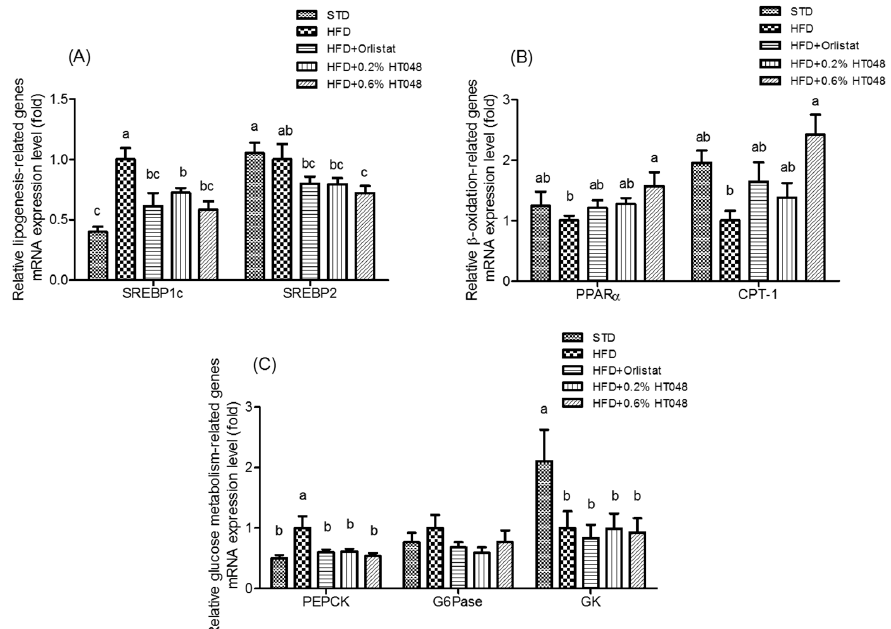
Figure 2. Effect of HT048 on mRNA expression of genes related to hepatic lipogenesis ( A ); β -oxidation ( B ); and glucose metabolism ( C ) in HFD-fed obese rats. Values are mean ± SD ( n = 12 for each group). Data were analyzed by one-way analysis of variance (ANOVA) followed by Duncan’s multiple range test. abc Means not sharing common letters are significantly different among the groups at p < 0.05.